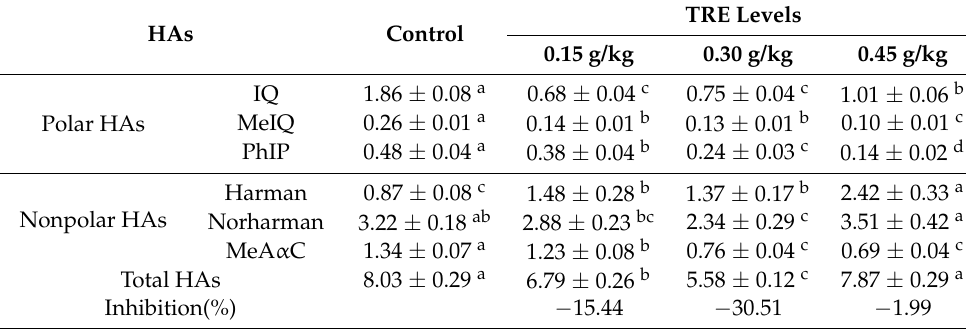
TRE Levels 0.15 g/kg